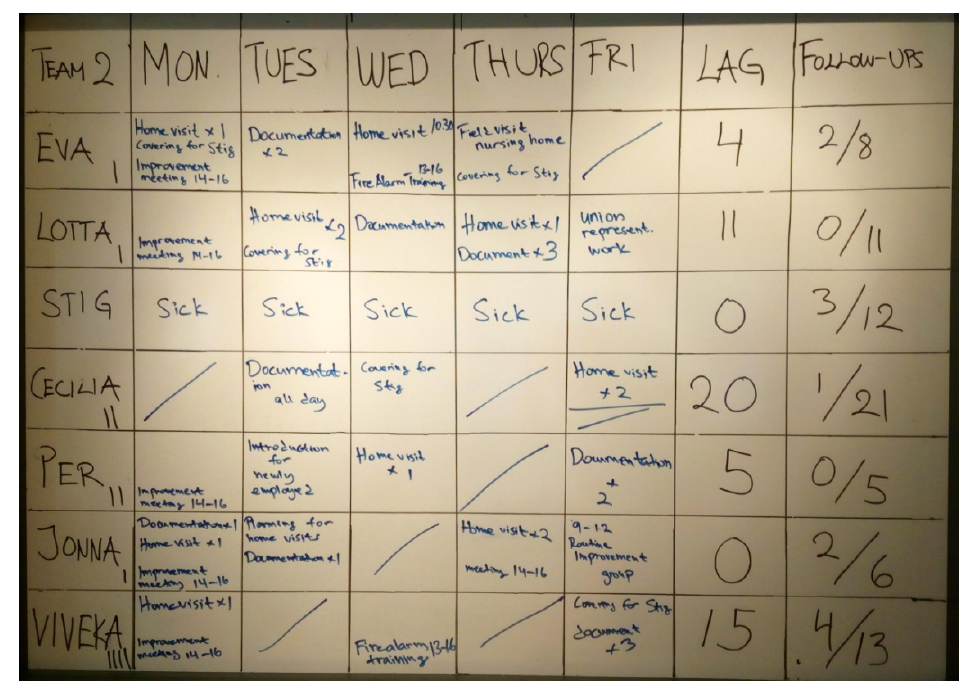
Figure 1. Whiteboard for Team